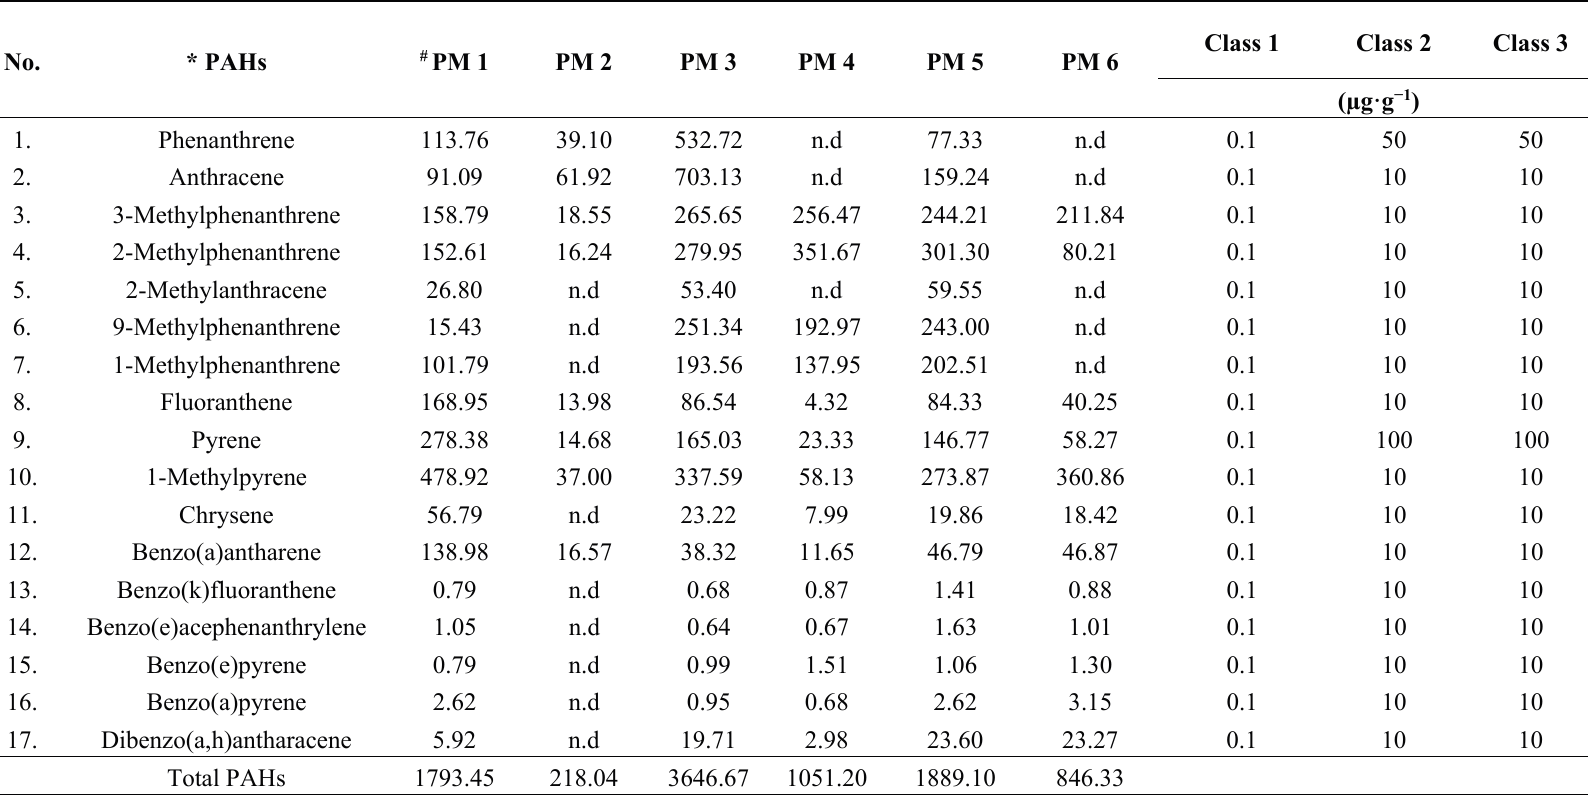
Table 3. Concentrations (ng·g − 1 , dry weight) of individual polycyclic aromatic hydrocarbons compounds in recycled paper mill sludges of different Malaysian paper